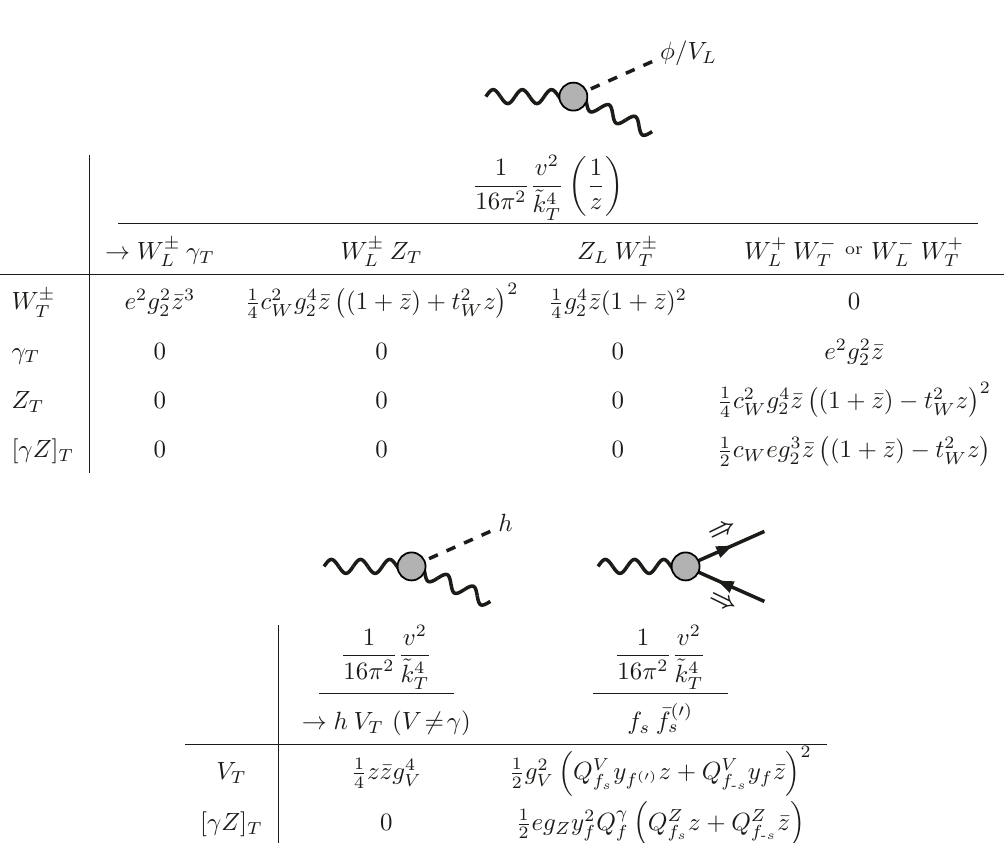
Table 5. Ultra-collinear transverse vector splitting functions d the off-diagonal incoming [ γZ ] T , the ˜ k 4 table 4 and in appendix